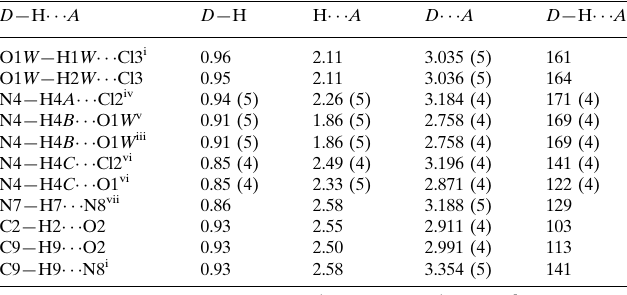
Hydrogen-bond geometry (A˚ , (cid:4)